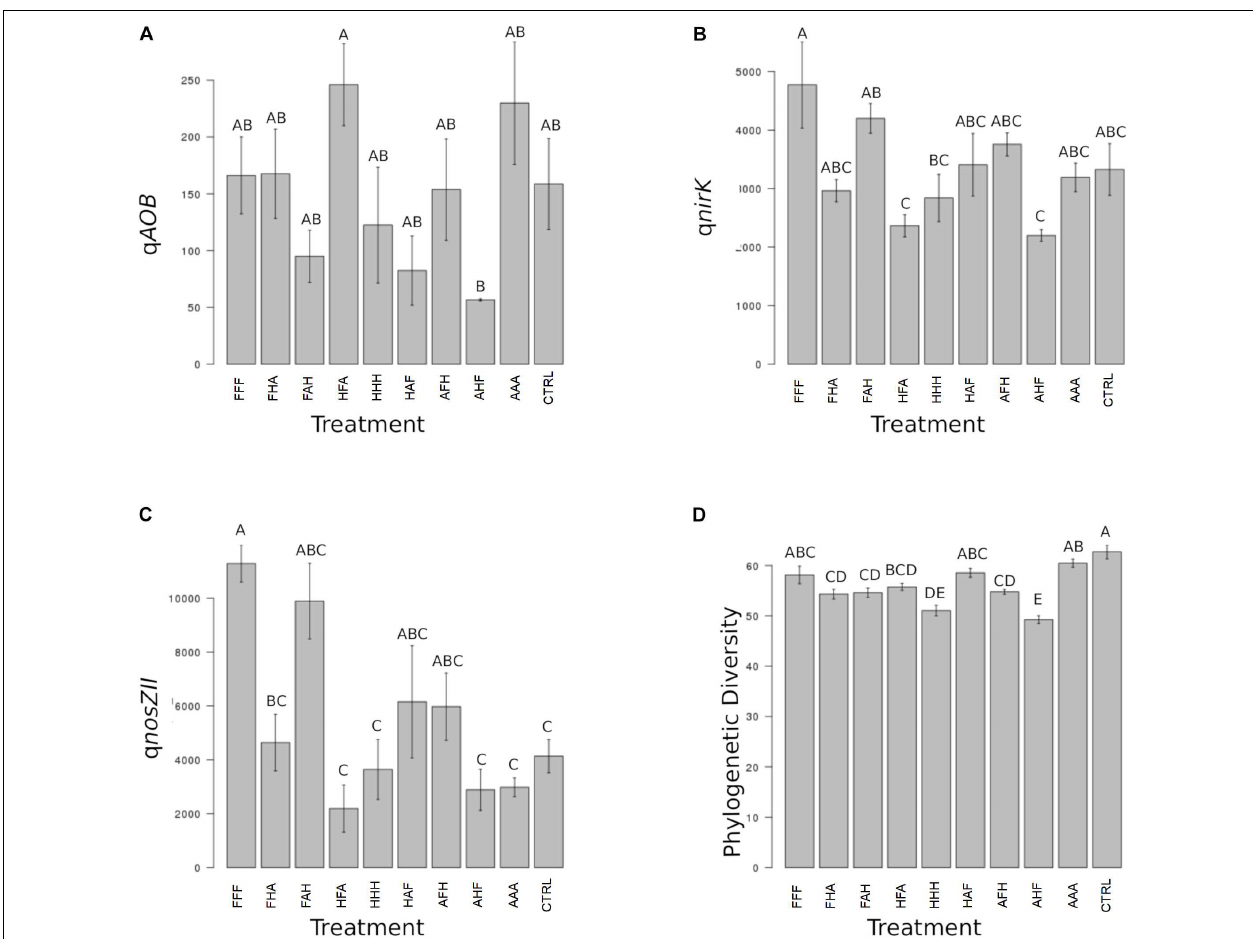
FIGURE 3 | Ecosystem properties significantly impacted by the chronology of compounded disturbance at T 3 . Different letters above the bars indicate significant differences according to Tukey’s test ( p < 0.05). (A) qAOB corresponds to the abundance of ammonia-oxidizing bacteria and is expressed in gene copies x g − 1 DNA. (B) qnirK corresponds to the abundance of bacteria harboring the nirK nitrite reductase gene and is expressed in gene copies x g − 1 DNA. (C) qnosZII corresponds to the abundance of bacteria harboring the nosZ clade II N 2 O reductase gene and is expressed in gene copies x g − 1 DNA. (D) Phylogenetic Diversity corresponds to estimates of the Faith’s phylogenetic diversity